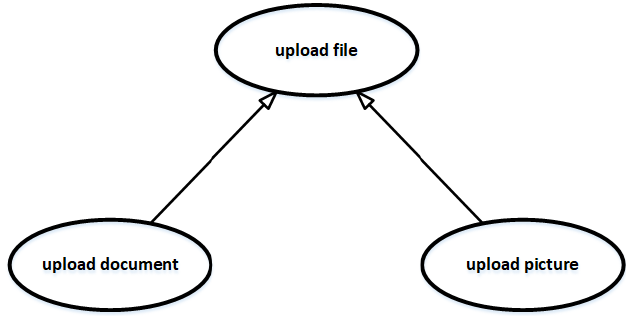
Figure 9. The generalize relationship between use